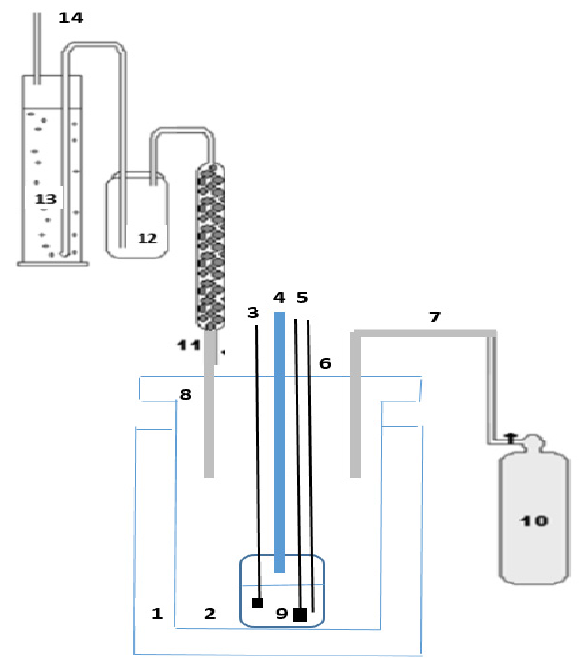
Figure 1. Experimental apparatus designed for corrosion tests in controlled atmosphere. 1: furnace, 2: molten salt reactor, 3: counter electrode, 4: thermocouple, 5: working electrode, 6: reference electrode, 7: gas inlet, 9: molten salt, 10: carrier gas, 8: o ff -gas system (which consisted of 11: MgO trap